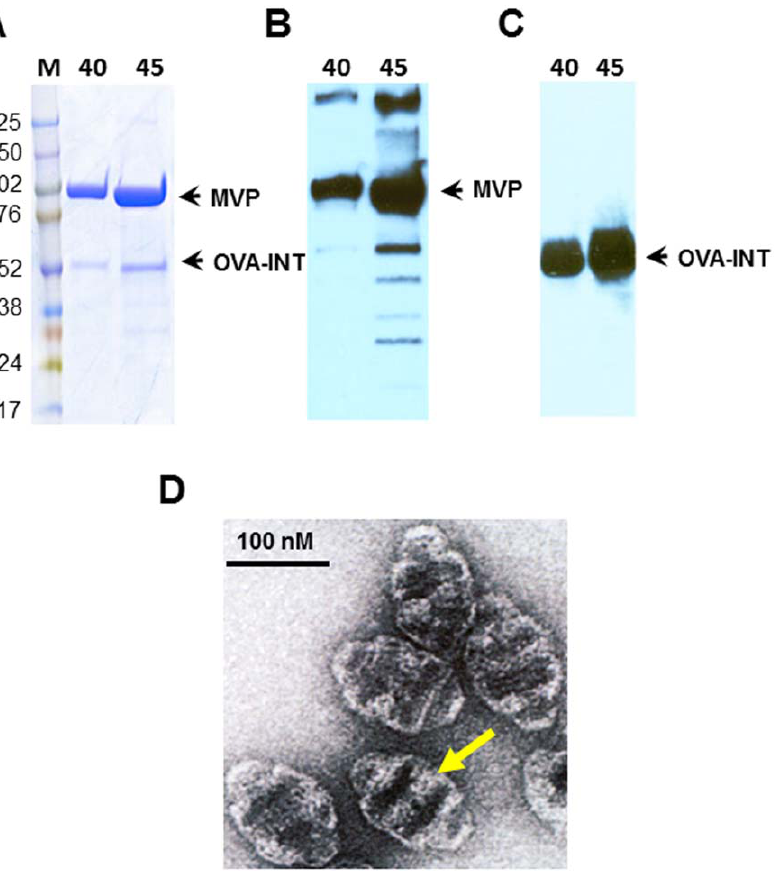
Figure 1. Analysis of purified recombinant vault particles containing OVA-INT. (A) Representative gel image showing co-purification of the protein species MVP and OVA-INT. Sucrose gradients of 40% to 60% run in SDS-PAGE (4%–15%). Lane: M: protein molecular weight markers, 40:40% fractions of sucrose gradient and 45% fractions of sucrose gradient. (B) The gradient fractions were probed with either anti-MVP rabbit polyclonal antisera or (C) anti-OVA rabbit polyclonal antisera. (D) Negative stain EM of CP-OVA recombinant vaults Bar, 100 nm.